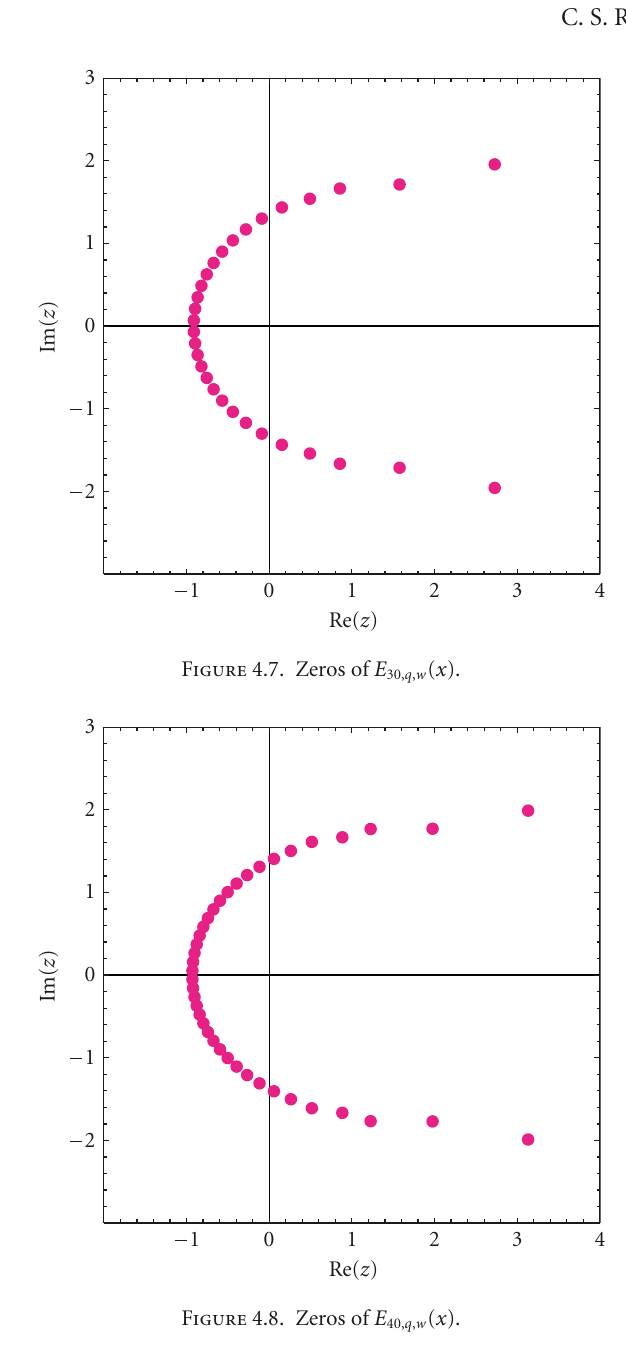
Figure 4.8 . Zeros of E 40, q , w ( x